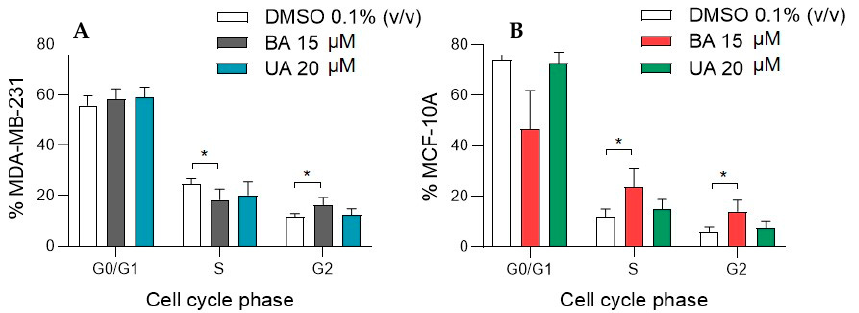
Figure 2. Cell cycle phase distribution of ( A ) MDA-MB-231 and ( B ) MCF-10A cells, treated with betulinic acid (BA) or ursolic acid (UA), for 48 h. DMSO was the solvent control. Each column and bar represent, respectively, the mean and the standard deviation. Four replicates considered. Statistically significant di ff erences between DMSO controls and BA or UA treated samples are indicated with * ( p -value < 0.05, Tukey’s